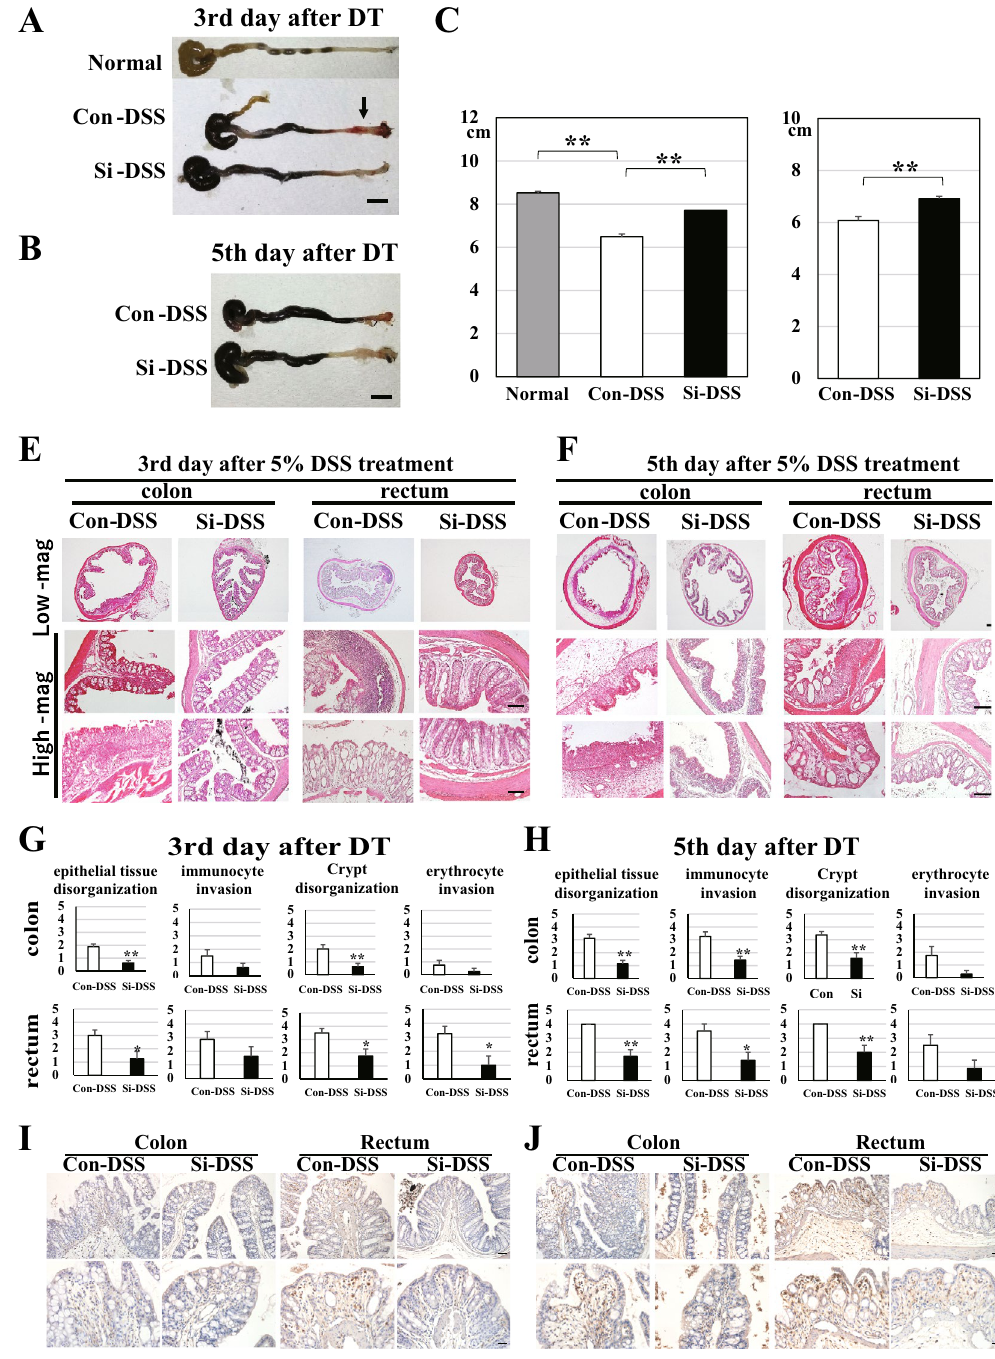
Figure 4. Si-based agent suppressed the atrophy and structural disorder associated with intestinal inflammation. Measurement and pathological analysis of the large intestine of 5% DSS-treated mice. ( A – D ) The representative photograph ( A , B ) and the bar chart indicate the average of the actual values ( C , D ) 3 days ( A , C ) and 5 days after DSS treatment ( B , D ). ( E , F ) The representative HE-staining photographs obtained 3 days ( E ) and 5 days after 5% DSS treatment ( F ). Low-mag: low magnification and High-mag: high magnification. ( G , H ) The average bar chart of each histological score 3 days ( G ) and 5 days after DSS treatment ( H ). DT: DSS treatment. Colitis: DSS treatment. Gray: normal mice (4 mice), white: Con-DSS group (8 mice), and black: Si-DSS group (3 days: 8 mice, 5 days: 7 mice). Scale bar: 1 cm ( A , B ), 100 µm ( C , D ). ( I , J ) The representative F4/80-immunostaining photographs obtained 3 days ( I ) and 5 days after 5% DSS treatment ( J ). Upper panels: low magnification and bottom panels: high magnification. Scale bar: 100 µm ( I ), 50 µm ( J ). Data are expressed as mean ± SEM. * p < 0.05, ** p < 0.01 vs . normal mice or Con-DSS, determined by Student’s paired t